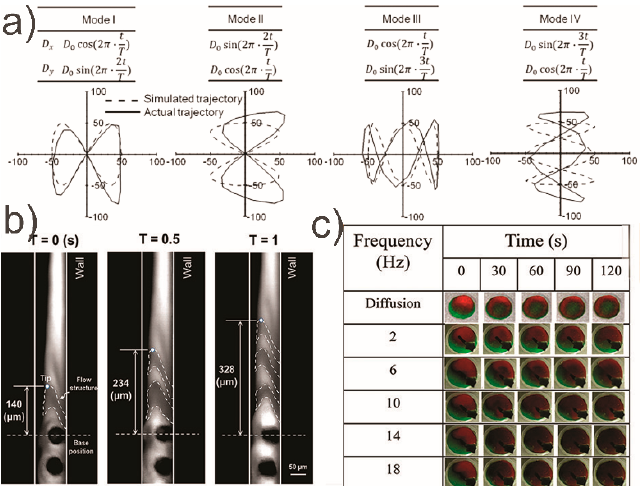
Figure 3. Results from the work depicted in Table 2. ( a ) The investigation of the dynamics of four beating configurations; reproduced with permission from [101], published by Elsevier, 2016. ( b ) Time lapse imaging of the flow induced by the vertical conical motion; reproduced from [102] under a Creative Commons BY license, published by MDPI, 2018., ( c ) Mixing by the cilium in a fluidic chamber for different times and frequencies; reproduced with permission from [104], published by IOP Science, 2016. In addition, chaotic advection must also develop in the fluid; mixing is certain to be poor unless flow in the microreaction chamber is chaotic. This chaotic motion may be introduced by adding passive structures on top of the cilia